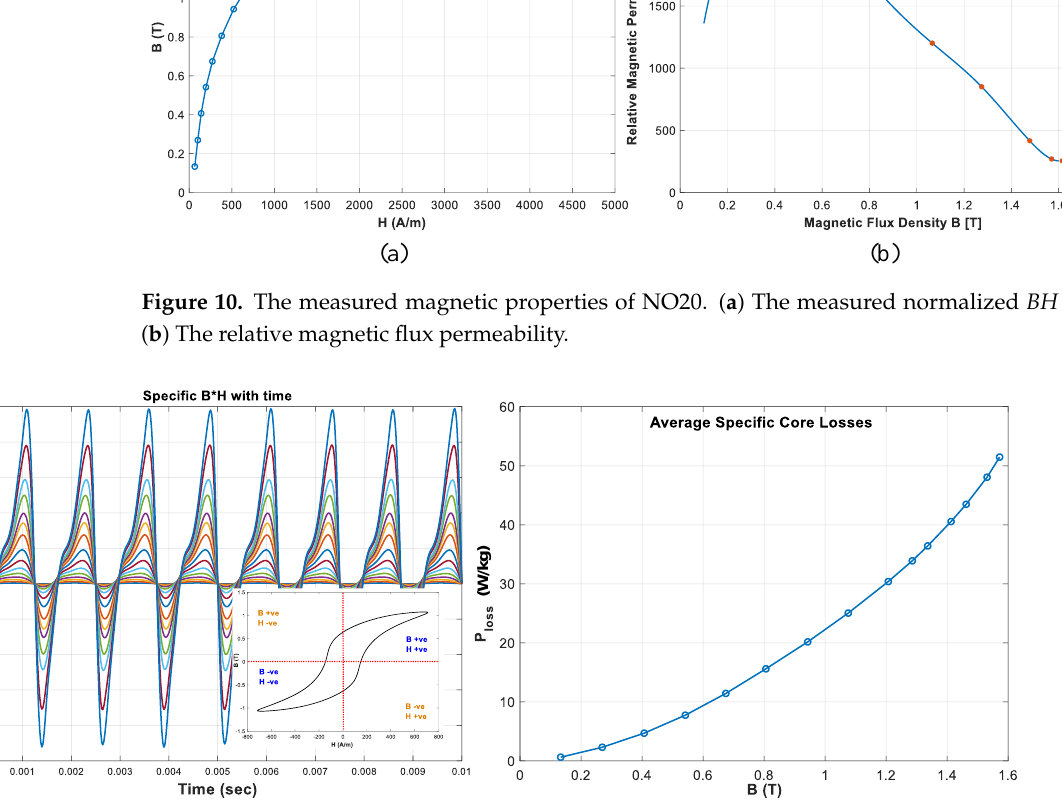
Figure 11. The measured core losses of the complete stator at 400 Hz. ( a ) BH ( t ) at different excitation levels (0.1 T–1.6 T). ( b ) Specific core losses.